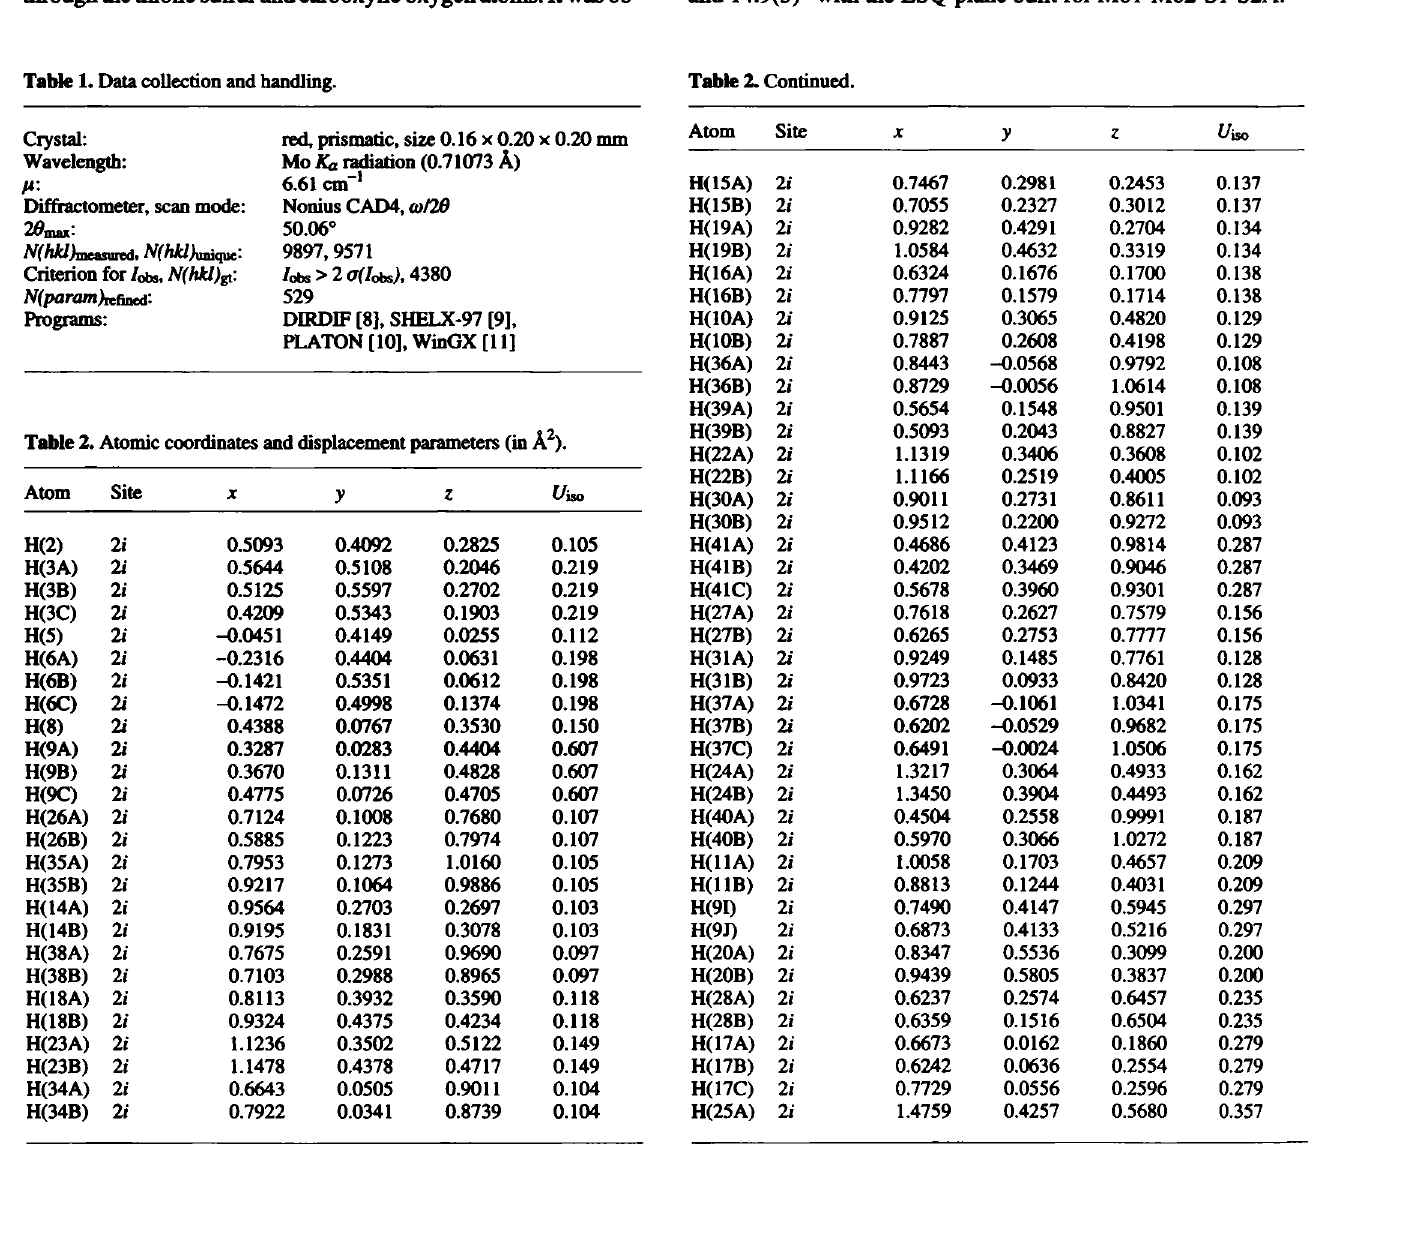
Table 2. Atomic coordinates and displacement parameters (in Ä 2